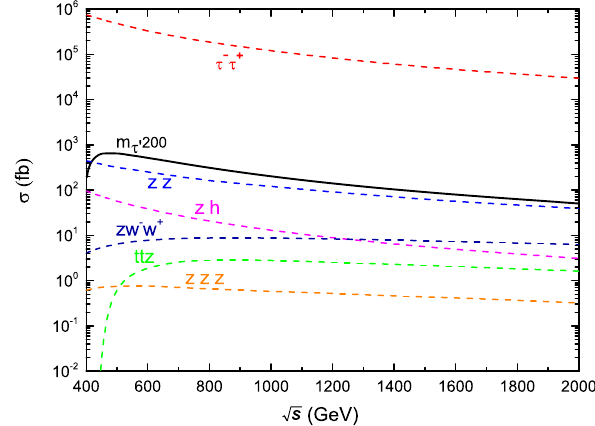
Fig. 5 The cross sections of the signal process for m τ (cid:2)± = 200 GeV and background processes as a function of